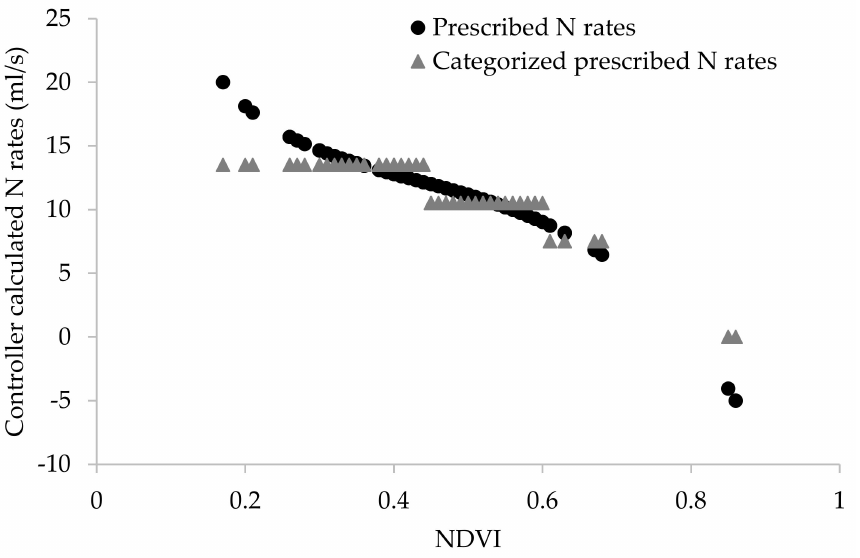
Figure 10. Controller–prescribed N rates (mL/s) and the controller-categorized N rates (mL/s) vs. controller-recorded NDVI values.